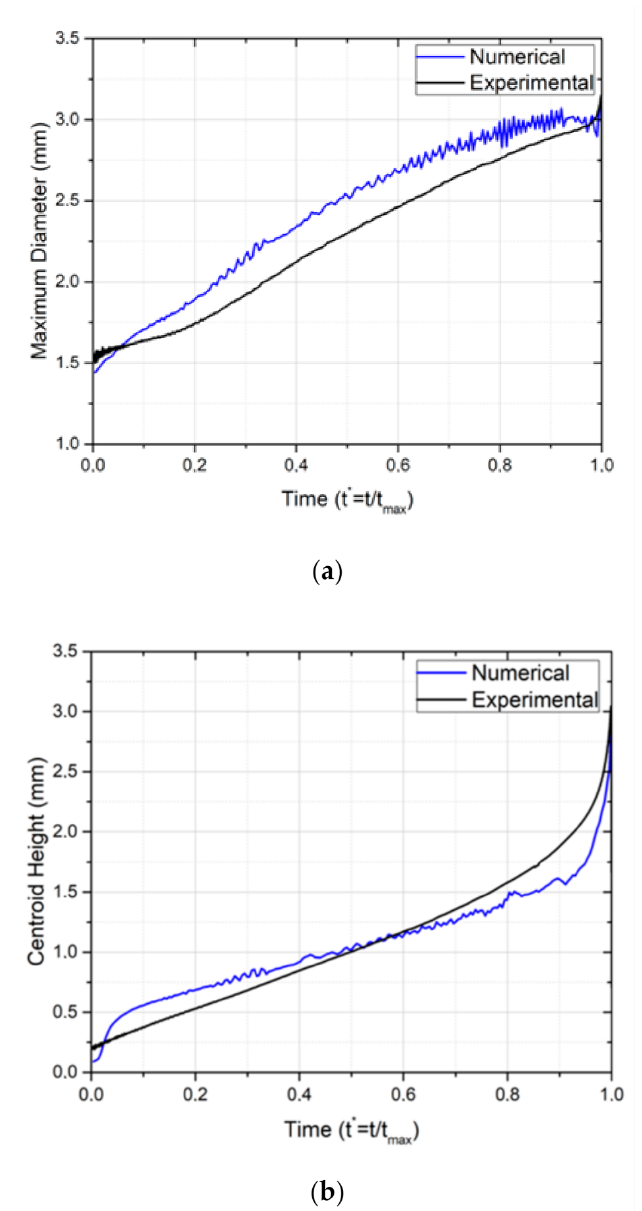
Figure 12. Comparison of bubble dynamic parameters for a superhydrophobic region with a diameter of 1.5 mm, a heat flux of 1290 W/m 2 and with water as working fluid. ( a ) Temporal evolution of the bubble maximum diameter. ( b ) Temporal evolution of the bubble centroid